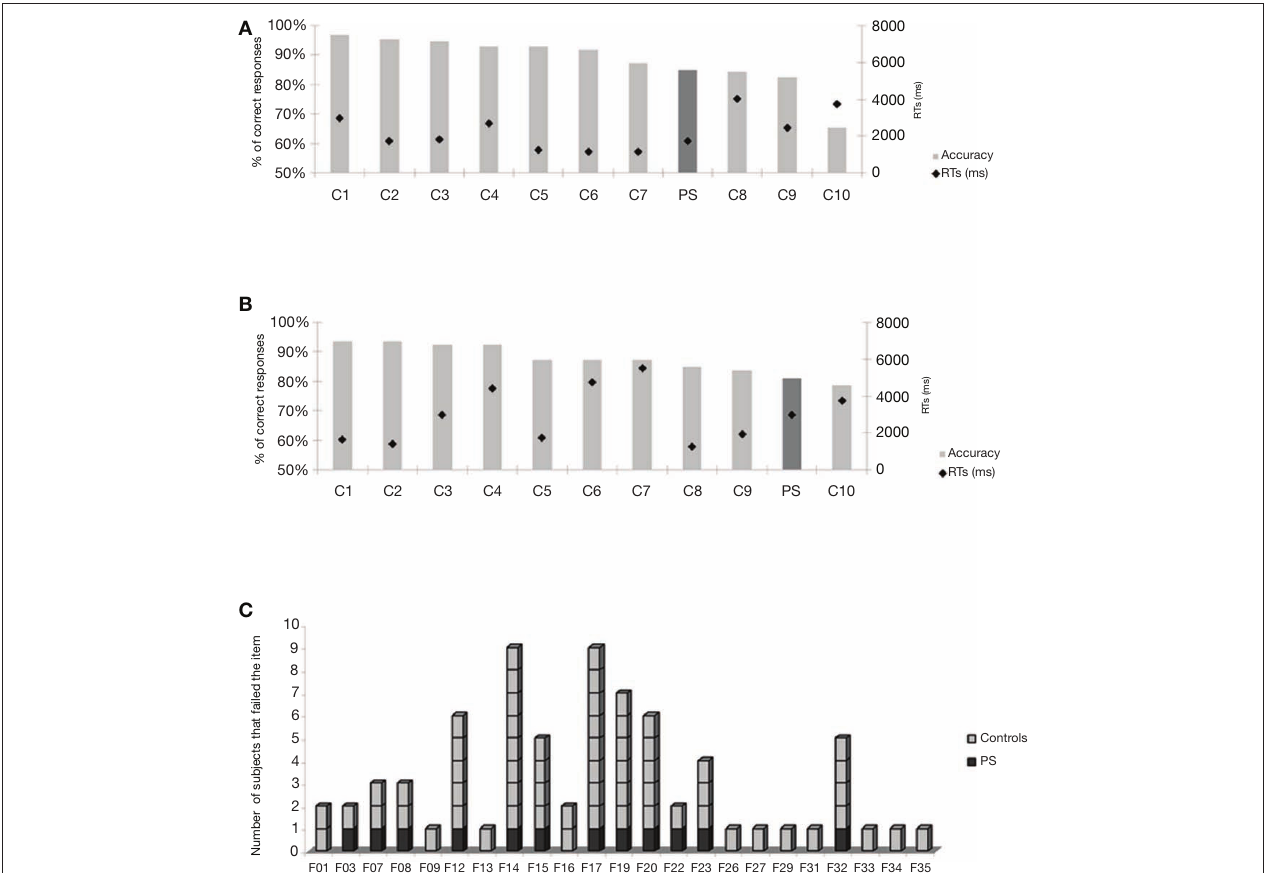
face decision task with Arcimboldo stimuli compared to control participants: all errors of PS were made on items that were also missed at least by one control participant, showing that her behavior in this task, qualitatively, does not differ from normal